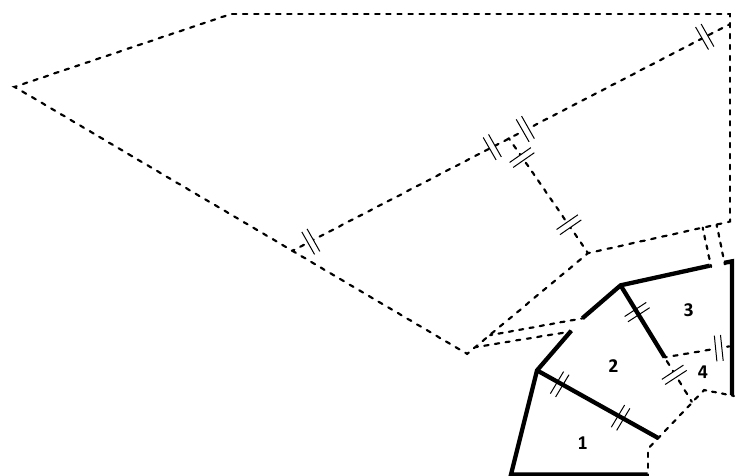
Figure 1. A map representing the inside and outside enclosure of the macaque housing facilities at the Biomedical Primate Research Centre (BPRC). The numbers indicate different inside compartments. Concrete walls are indicated by thick black lines, the dotted lines indicate wire mesh, and the thin black lines indicate sliding doors that connect the different compartments. 1: initial housing of new male: olfactory, auditory and limited visual contact; 2: housing of the female group; 3: housing of new male during familiarization phase: visual interactions only; 4: housing of new male during familiarization phase: visual contact and physical interaction through wire mesh. Various steps are described in detail under 2.3 and 2.4.